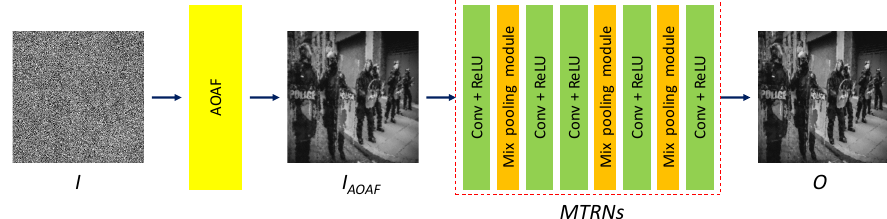
Figure 1. Flowchart of the proposed denoising